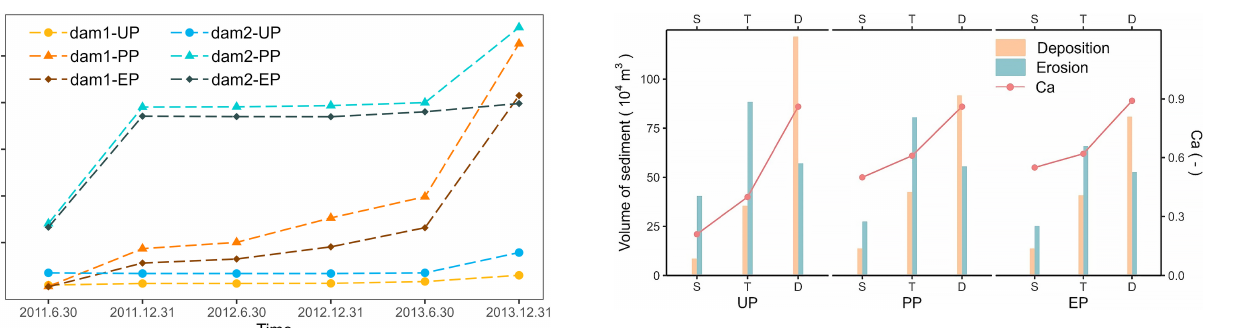
Figure 9. The volumes of sediment and the conservation ability (Ca) in the three areas for each scenario (S: source area, T: tran- sitional area, D: deposition